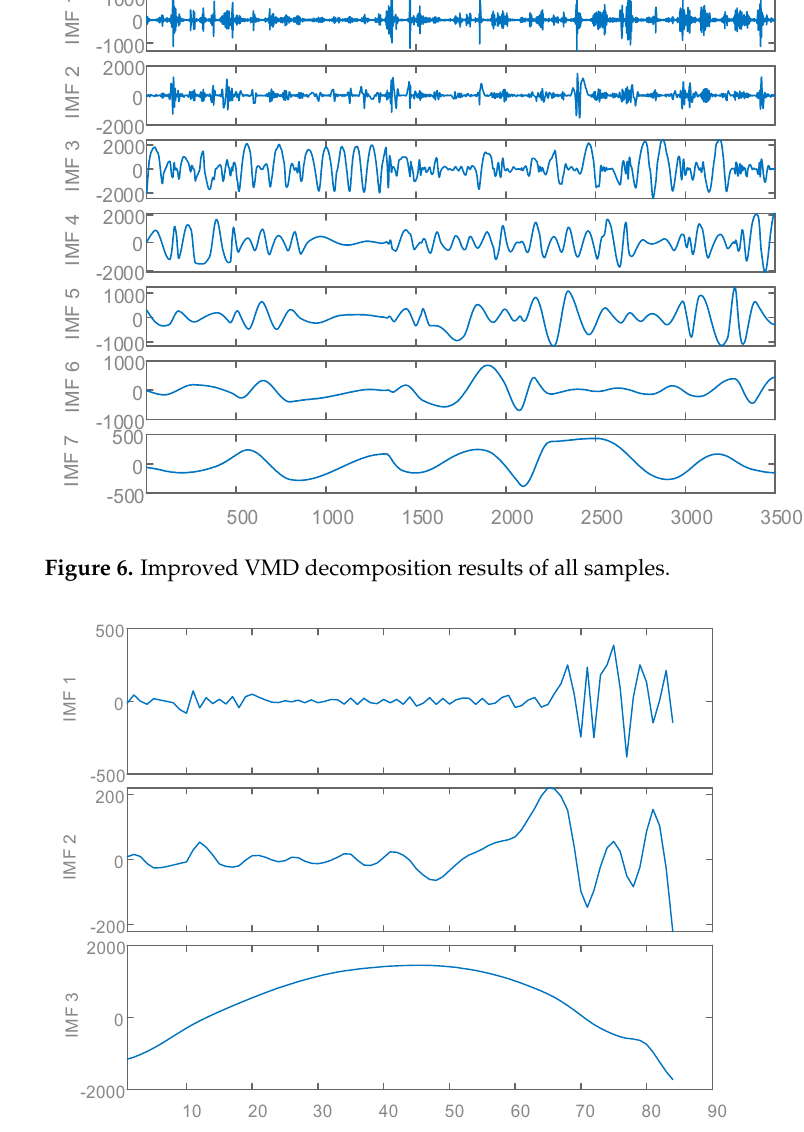
Figure 7. Exploded view of samples with slow weather changes.